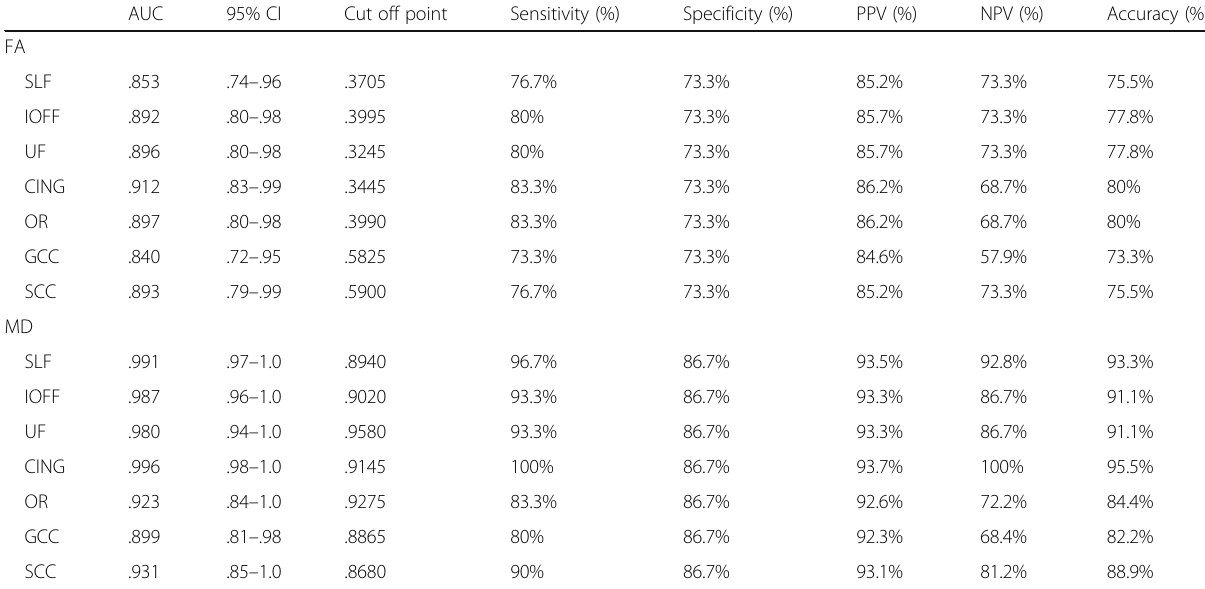
Table 2 The performance of FA and MD in assessing cerebral white matter integrity